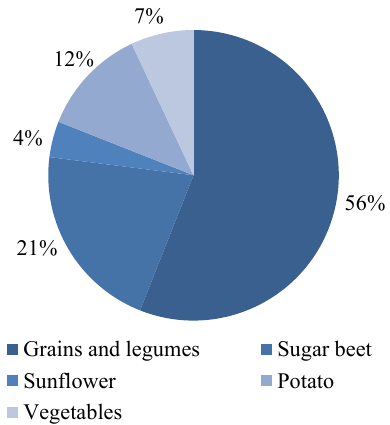
Figure 1 Scheme of the roller type activator mill Figure 2 Croppage distribution in